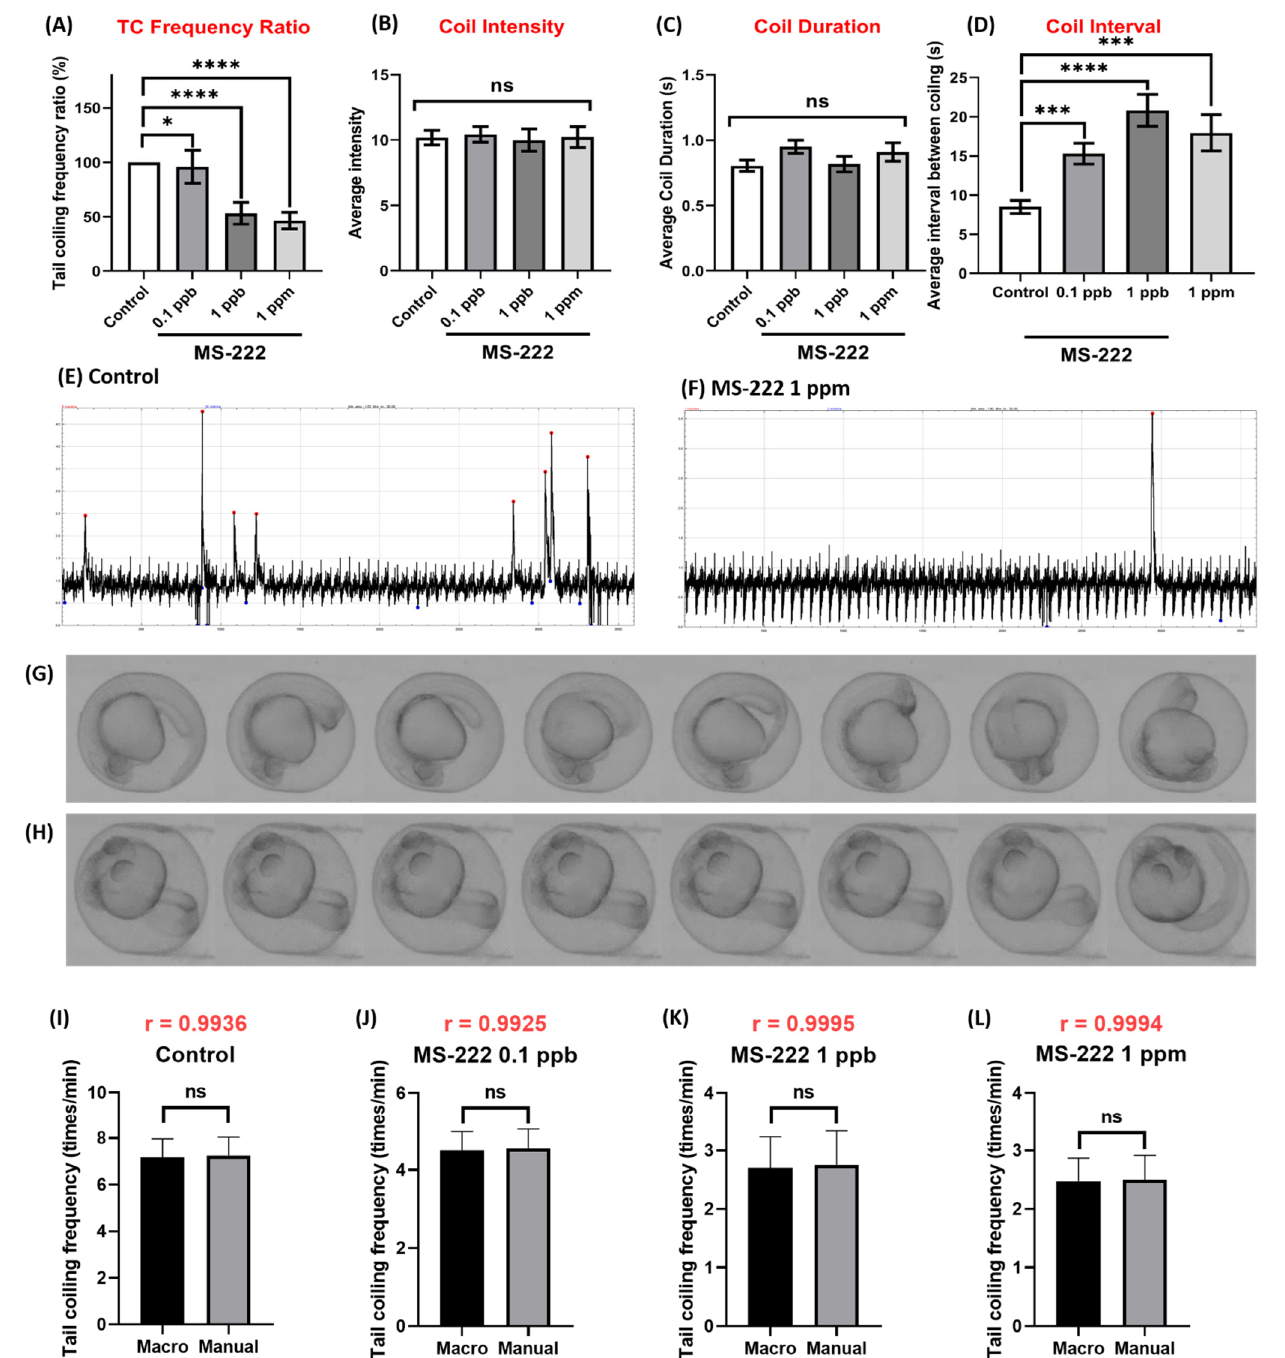
Figure 7. Comparison of tail coiling activity for zebrafish embryos at 24 hpf for control and MS-222 exposure. ( A ) Quanti- tative comparison of tail coiling frequency ratio, ( B ) average intensity, ( C ) coil duration and ( D ) coil interval of zebrafish embryos treated with different doses of MS-222. The representative tail coiling peak obtained from either ( E ) control or ( F ) 1 ppm MS-222 exposed zebrafish. Time-lapse comparison showing tail coiling movement in zebrafish embryo after receiving either ( G ) 0 or ( H ) 1 ppm MS-222. Statistical validation is carried out using Kruskal-Wallis test. Data are presented as Mean ± SEM, n = 40. ( I – L ) Statistic comparison of data collected by either TCMacro or manual counting for either ( I ) control, ( J ) MS-222 0.1 ppb, ( K ) MS-222 1 ppb or ( L ) MS-222 10 ppb treated embryos. The statistical difference is double validated using Pearson correlation (black color) and Wilcoxon test (red color). Data are presented as Mean ± SEM, n = 40 (* p < 0.05, *** p < 0.001, **** p < 0.0001, ns p > 0.05).